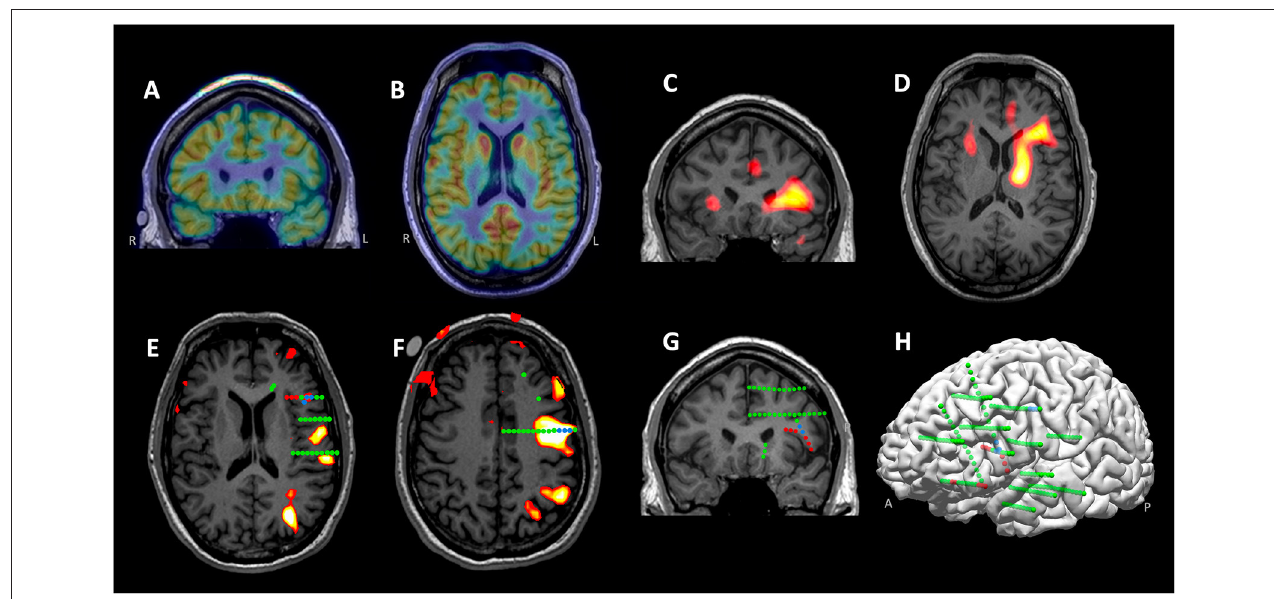
FIGURE 9 | MMII findings in Case 3. (A,B) Prominent hypometabolism in the left inferior frontal region revealed on the coronal and axial PET. (C,D) Ictal SPECT (coronal and axial) showing bilateral hyperperfusion, more involved in the left inferior frontal cortex. (E,F) 3T language fMRI activation (during a covert word generation task) overlaid with SEEG electrodes, shown on two different MRI slices key to the cortical stimulation findings. SEEG Ictal onset arose from the left frontal operculum with network involvement of the orbitofrontal cortex, as denoted by red spheres. Speech arrest was elicited by stimulation at high intensity in the white matter tract underlying pars triangularis and in the dorsal aspect of pars opercularis (both shown with blue spheres). (G,H) Left-sided SEEG implantation shown on 2D coronal slice and 3D view. The implantation (all implanted electrodes shown with green spheres) covered the left frontal, temporal, insular and opercular regions, especially with key trajectories targeting the PET and ictal SPECT localizations. Following intraoperative language mapping, the patient underwent a resection of the left orbitofrontal cortex, the anterior short gyrus of the insular and frontal operculum. He remained seizure free for 18 months at the most recent follow up, and had no language deficits since surgery. Histopathology showed FCD type